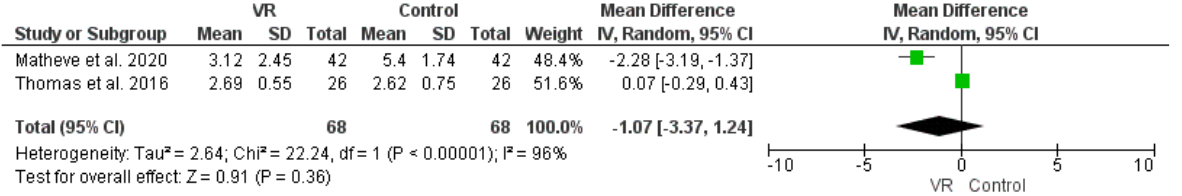
Figure 5. Effect of VR and control on PPI. Green squares represent mean difference for each study, while black rhombus represents the aggregated average of the mean differences.